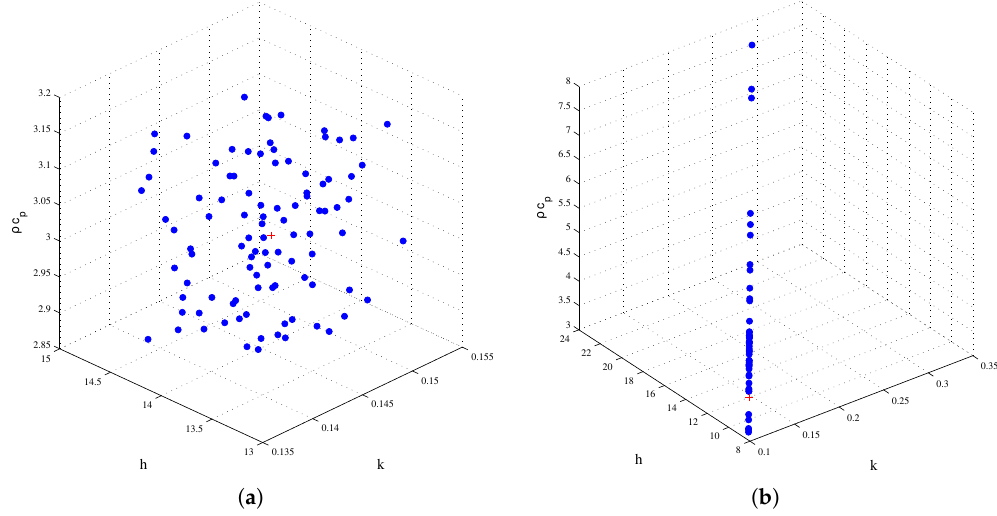
Figure 4. Initial guesses ( a ) and convergence points ( b ) for the LM algorithm in a three-dimensional parameter space. Table 1. Results of parameter estimation with synthetic data for ( a ) p t and ( b ) α t obtained from p t . One hundred random initial guesses were used to estimate ¯ p fit , which is the average of the optimal estimates. The two columns in p t refer to k , ρ c p ,